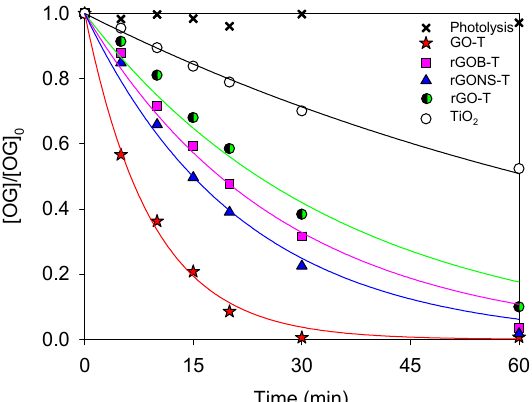
Figure 5. Normalized concentration of OG (Orange G dye) as a function of time in photolysis and photocatalysis (TiO 2 , rGO-T, GO-T, rGONS-T, and rGOB-T). Table 2. OG conversion after 60 min ( X OG ), pseudo-first order kinetic rate constant ( k app ), and regression coefficient ( r 2 ) of OG.